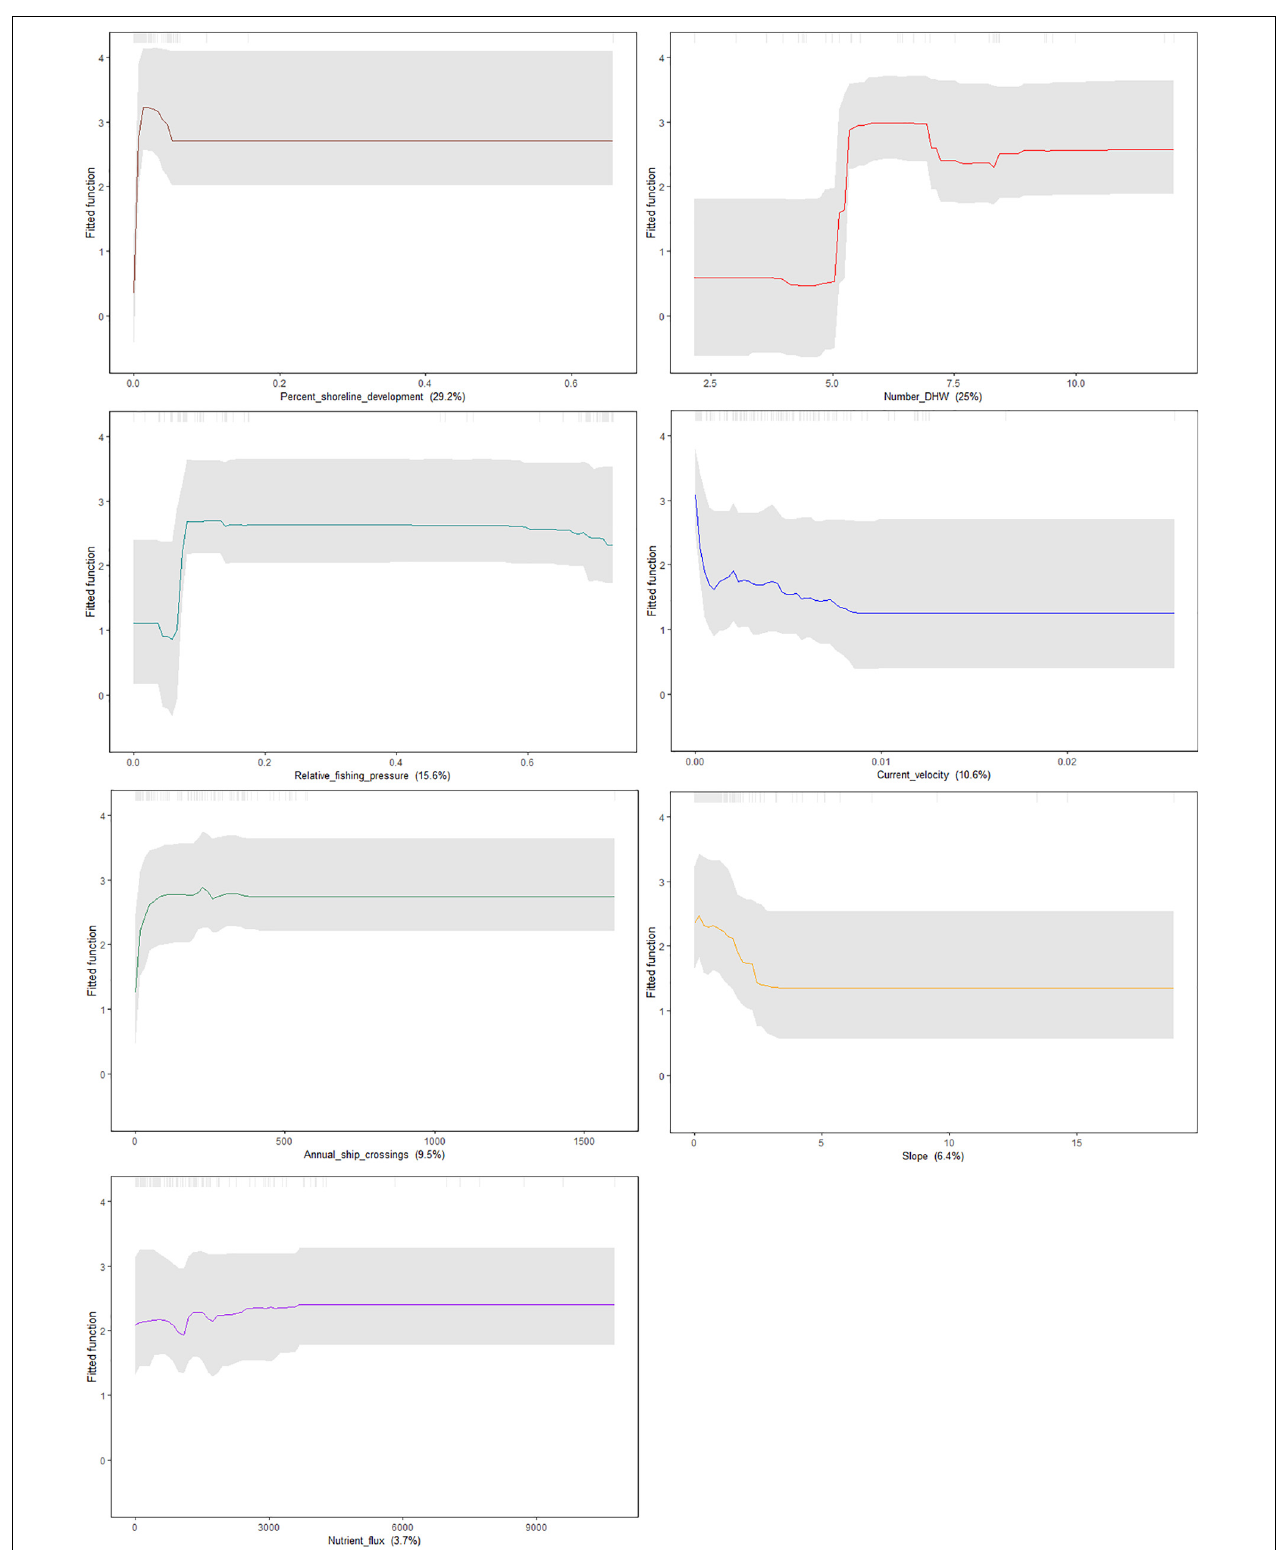
FIGURE 5 | Partial dependence plots showing the marginal influence of each predictor (denoted in parentheses below each plot) on the probability of occurrence of A. amadelpha. Confidence intervals were generated by bootstrapping the model predictions 100 times and are signified by gray dashed lines.